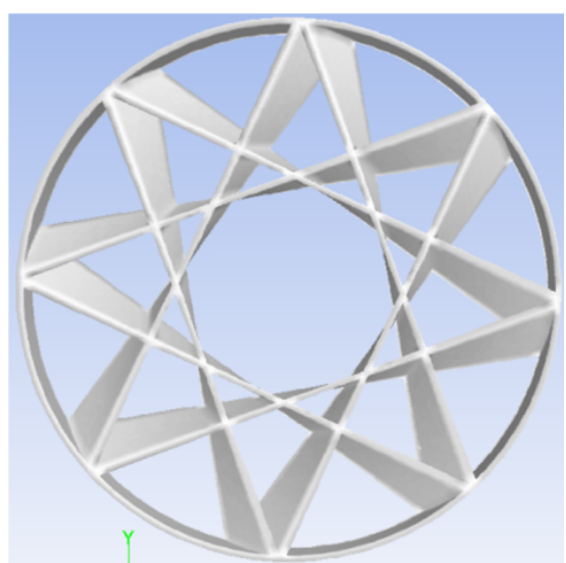
Figure 2. Modeling of